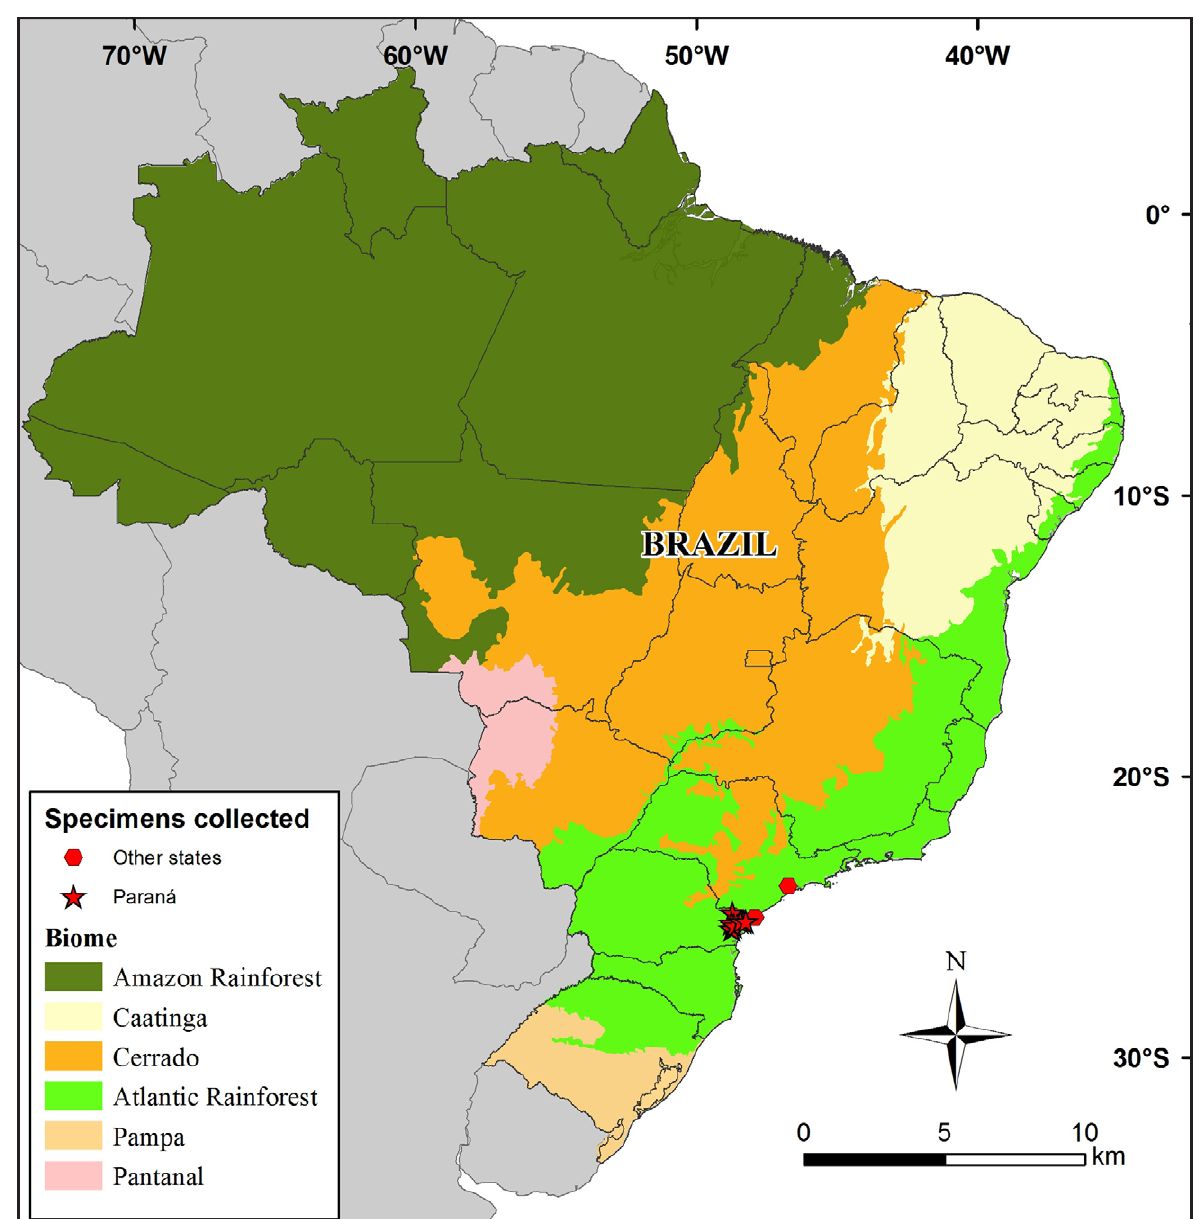
Figure 4. Distribution of Cinnamodendron occhionianum F.Barros &